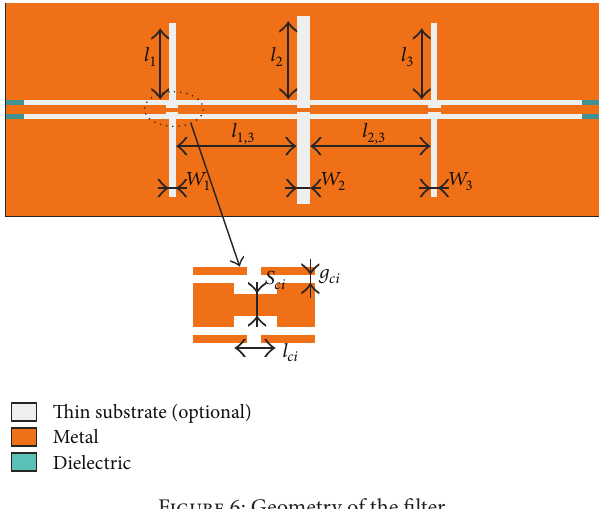
Figure 6: Geometry of the